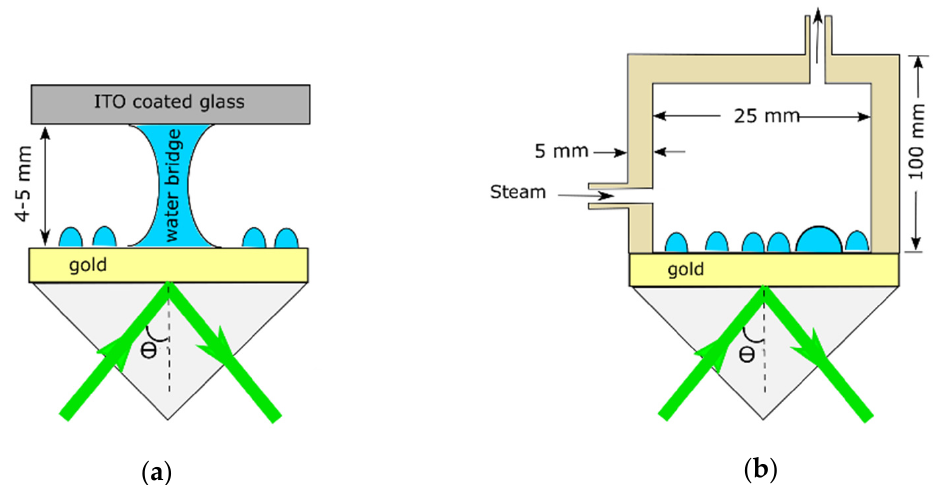
Figure 1. Schematic of the experimental setup for ( a ) stable dropwise condensation (SDC) and ( b ) unstable dropwise condensation (USDC) studies. Two wavelengths of 550 nm and 680 nm with the incident angles ( θ ) of 44.80 degrees and 43.15 degrees, respectively, were studied.